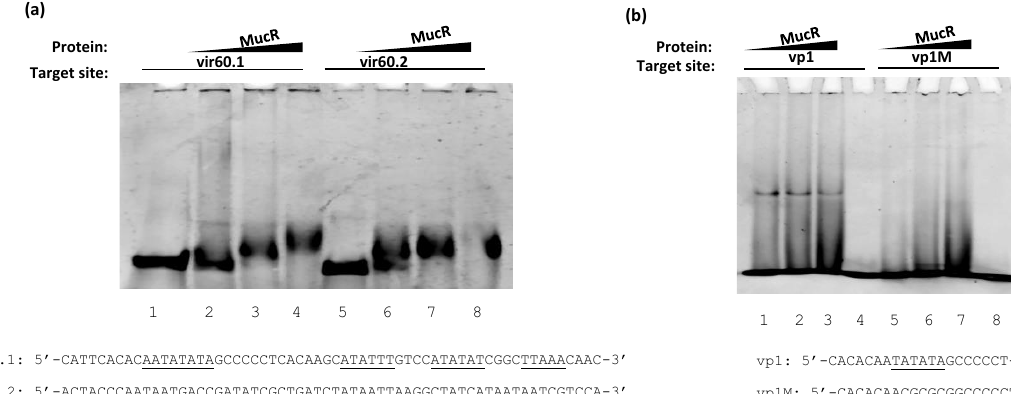
Figure 3. The promoter region of virB operon. The sequence reported spans from the thymine occupying the position 67,081 on chromosome II of B. abortus 2308 to the guanine in position 70 in the virB1 gene sequence. The thymine constituting the transcription starting site is in bold red and underlined. The oligonucleotides vir60.1 and vir60.2 tested as DNA target sites of MucR are in green or red, respectively, while the 20 bp oligonucleotides vp1 is underlined.